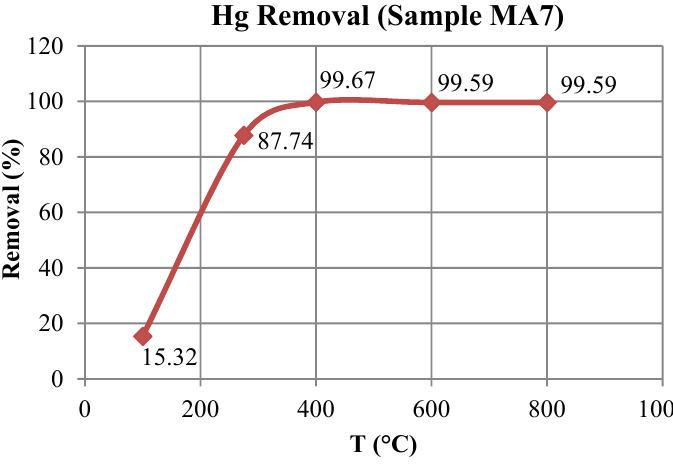
Figure 6. Evolution of mercury removal during the treatment of sample